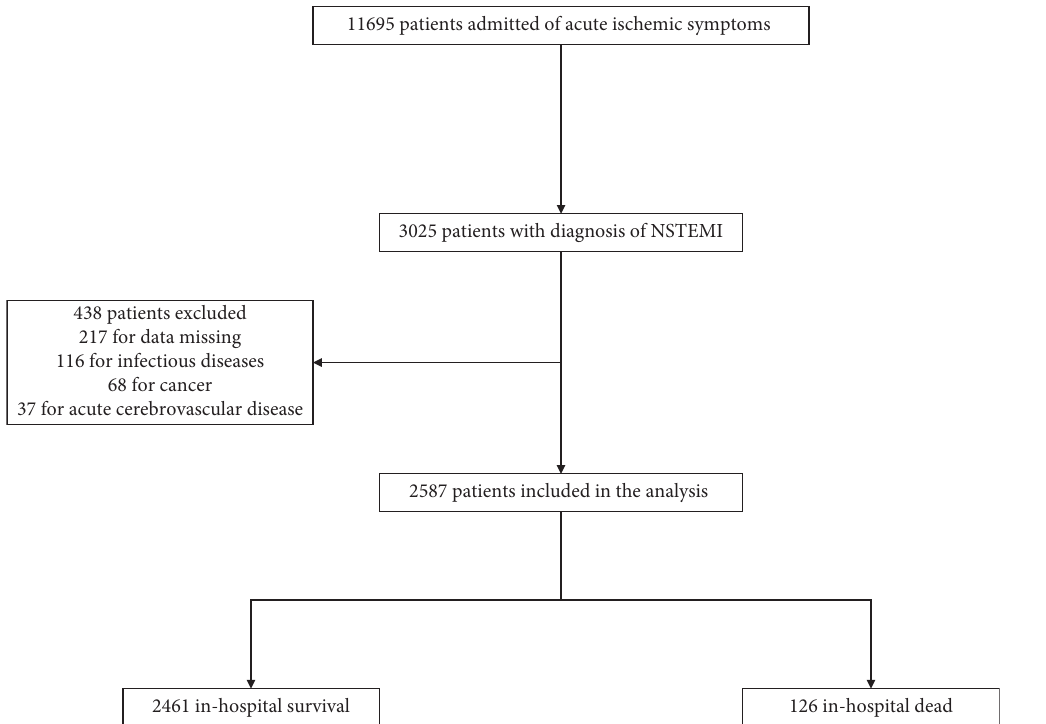
Figure 1: The flow diagram. NSTEMI: non-ST-segment elevation myocardial infarction. Table 1: Baseline characteristics of patients who died vs.